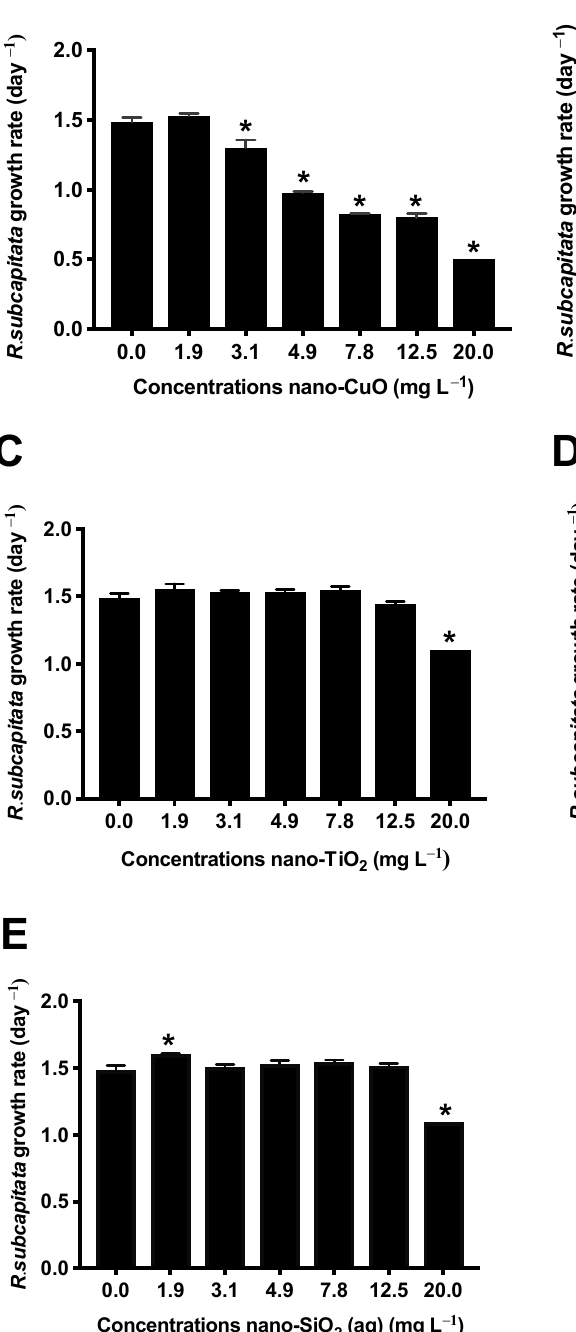
Figure 1. R. subcapitata growth rate after 72 h of exposure to nano-CuO ( A ), nano-ZnO ( B ), nano-TiO 2 ( C ), hydrophilic nano-SiO 2 ( D ), nano-SiO 2 (aq) ( E ). The experiments were conducted in triplicate and the results are shown as the mean ± standard deviation (ANOVA followed by Dunnett’s test, * p < 0.05 compared to control).